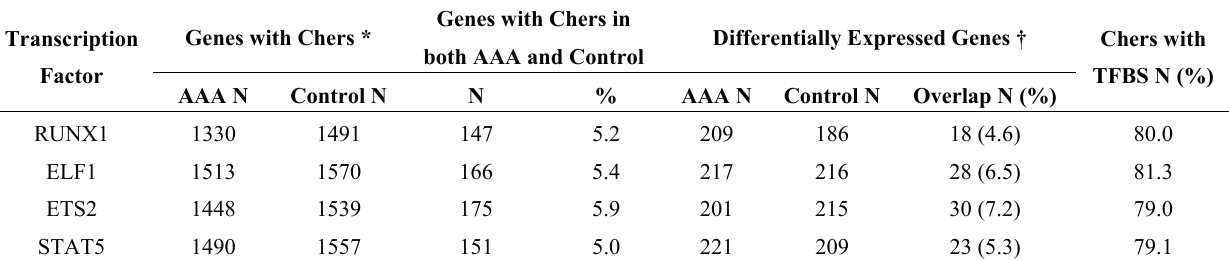
Table 3. Number of genes with chers, genes with differential expression in AAA, and chers with TFBSs.